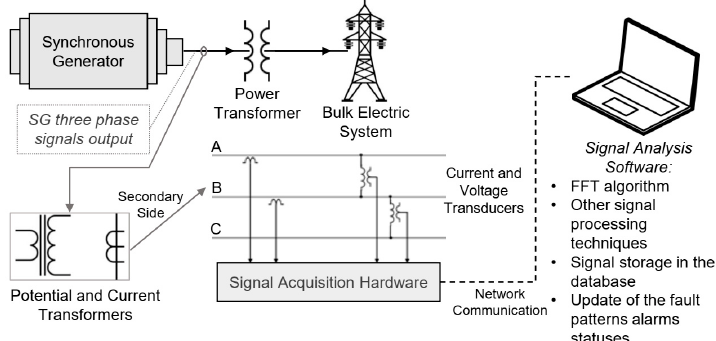
Figure 3. Electrical signature analysis (ESA) based methodology for condition-based maintenance of synchronous generators (SGs).